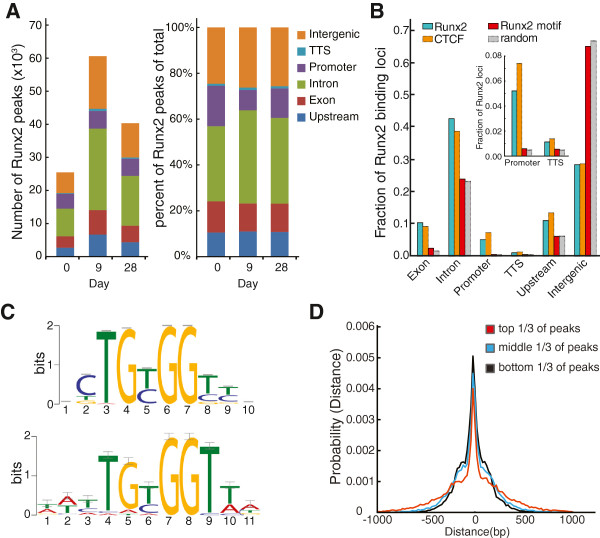
Genome-wide profile of Runx2 occupancy. (A) Distribution of Runx2 binding peaks across the mouse genome were classified into six categories of genomic locations: exon, intron, promoter (-1 kb to +150 bp of TSS), upstream (-1 kb to -20 kb from TSS), TTS region (-150 bp to -1 kb of transcription termination site), and intergenic region. Peak distribution was plotted at each time point by peak number (left panel) and by the percentage of total peaks (right panel). (B) Differential Runx2 enrichment in the six categories of genomic locations compared to the predicted Runx2 motif (see below), to random binding, or to binding of the transcription factor CTCF. Inset provides a magnified view of promoter and TTS regions. (C) The 500 most significant Runx2 peaks, based on MACS [22] significance (P < 1 × 10-10) were used for de novo motif discovery. A Runx2 motif (position weight matrix, top) with strong statistical confidence (P = 4.7 × 10-200) was determined using MEME (MEME suite version 4.7.0) [24]. The known Runx motif (MA0002.2, bottom) in JASPAR [26] was used for comparison using TOMTOM [24]. As shown in (B), the distribution of de novo Runx2 motifs among categories of genomic locations was determined using FIMO [24] at a significance threshold of P < 10-4. (D) Probability plot of the distribution of Runx2 peaks indicating the distances of Runx2 motifs to the peak centers in the top, middle, and bottom third of Runx2 peaks (ranked by MACS scores) versus the probabilities of finding de novo Runx2 motifs at given positions relative to peak center.